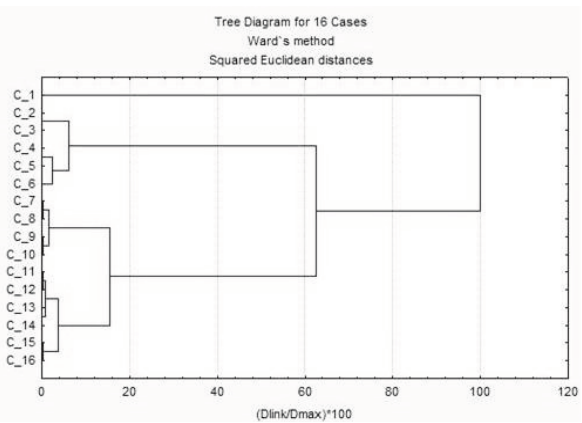
Figure 1: Hierarchical dendrogram of 16 glass objects with different glass